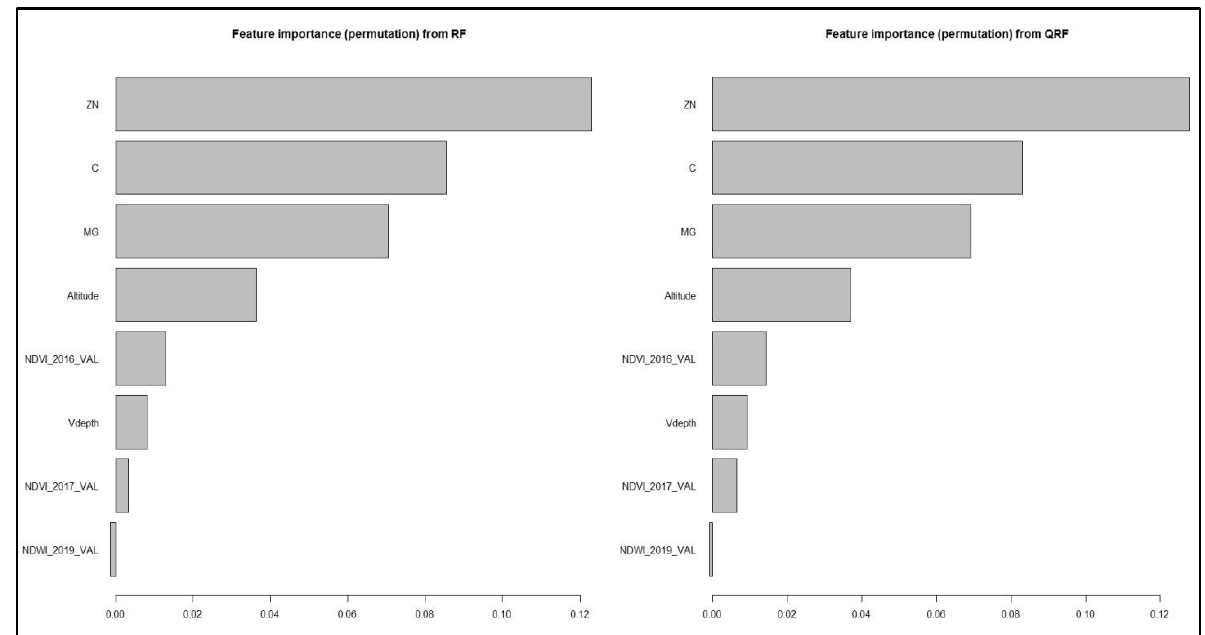
Figure 8. Hyperparameters assessment results based on R 2 in the training dataset.